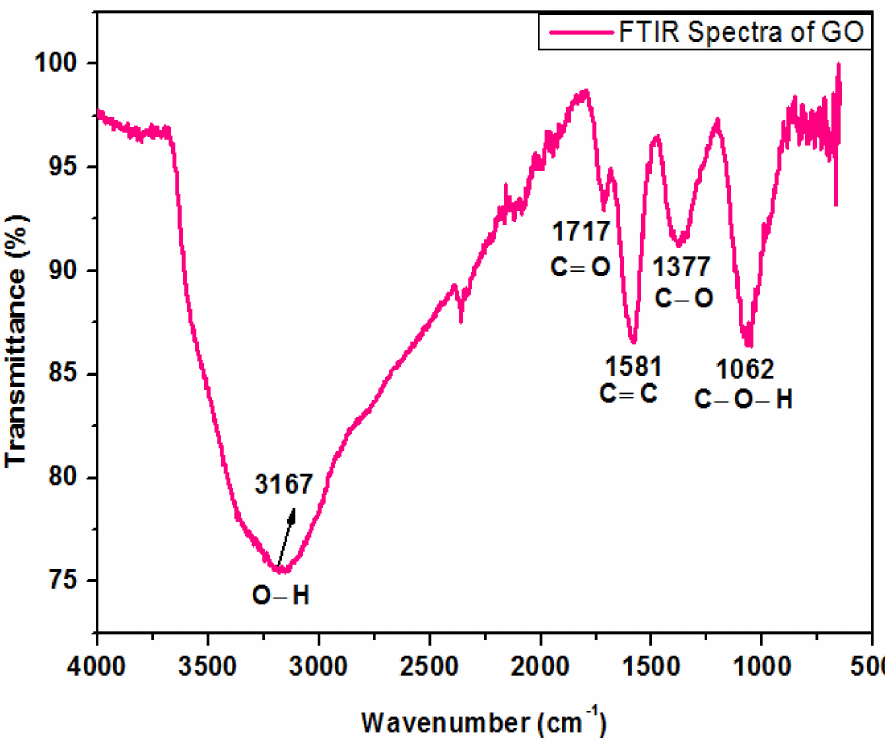
Figure 4. FTIR spectrum of graphene